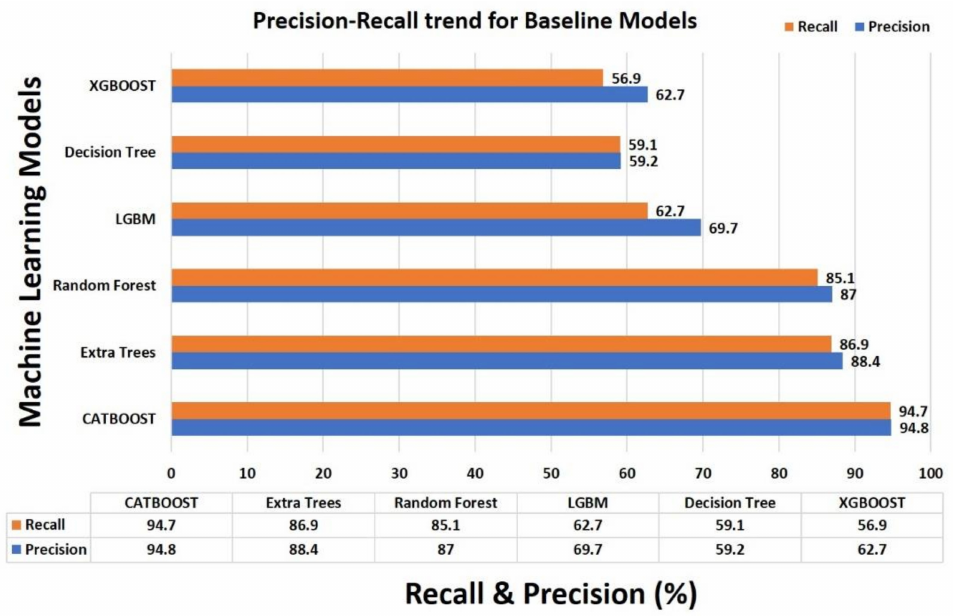
Figure 7. Baseline models Precision-Recall trends